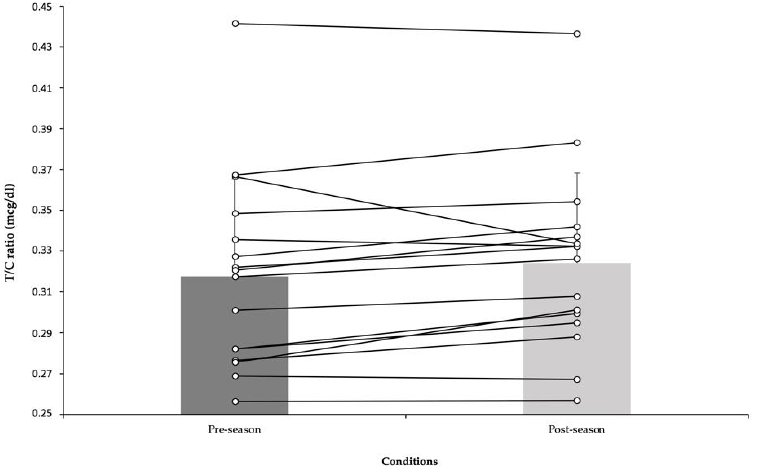
Figure 1. Before and after pre-season data (mean ± SD) of testosterone/cortisol ratio. Regarding training load data, a paired measures t -test revealed no significant differ- ences between before and after the pre-season period for urine color, stress, fatigue, sleep quality, and soreness measures. There was a significant increase in the Hooper Index, RPE (general), RPE (breath), RPE (neuromuscular), sRPE (general), sRPE (breath), and sRPE (neuromuscular) after pre-season compared to before pre-season (see Table 3, for more